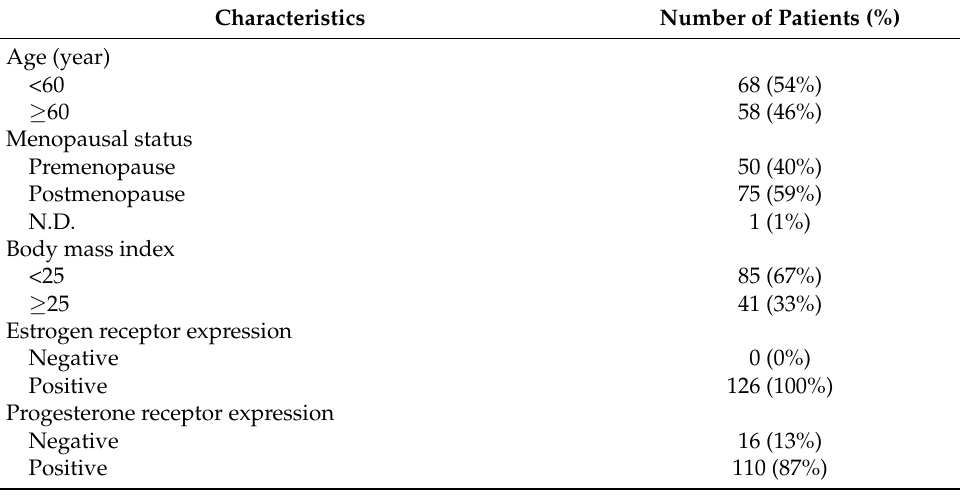
Table 1. Clinicopathologic characteristics of 126 BC